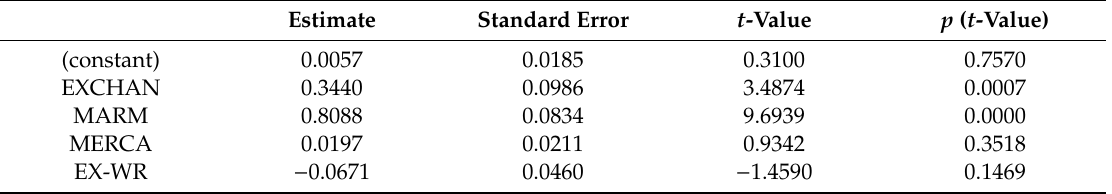
Table A2. Regression coe ffi cients for the model of the field prices of oranges without considering the time (MONTH), AREA, or variety (VAR)